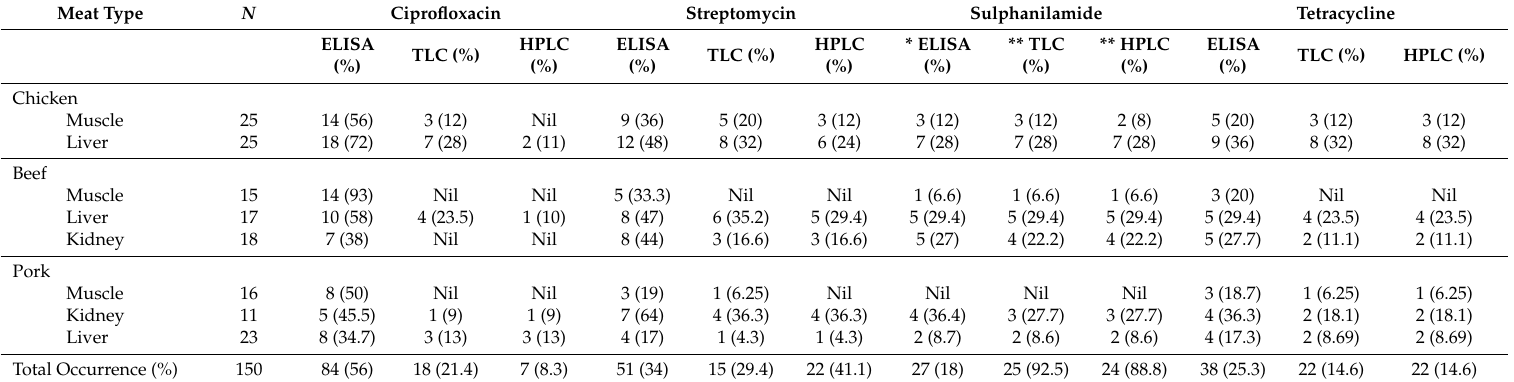
Table 1. Occurrence of antibiotic residues in meat samples using ELISA, TLC, and HPLC methods.